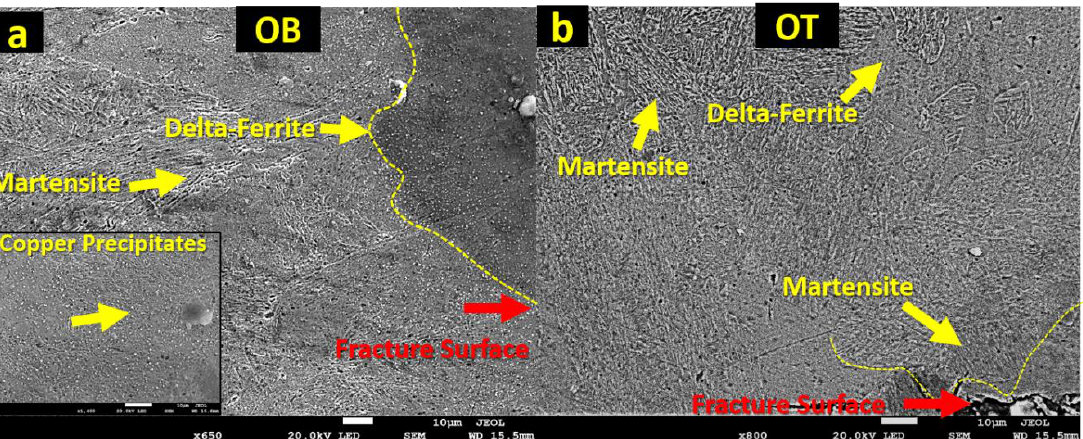
Figure 18. The chemically etched images of necked section of ( a ) OB and ( b ) OT obtained with the aid of SEM.